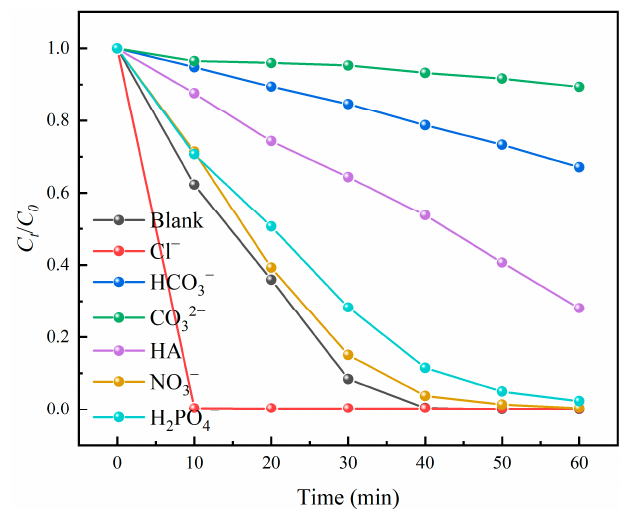
Figure 11. Effect of co-existing anions and HA on RhB degradation. Control condition: (850CC) = 1.0 g/L, (PMS) = 1.0 mM, temperature = 30 °C, (Cl − ) = (NO 3 − ) = (HCO 3 − ) = (CO 32 − ) = (H 2 PO 4 − ) = 0.2 M, (HA) = 20 mg/L.